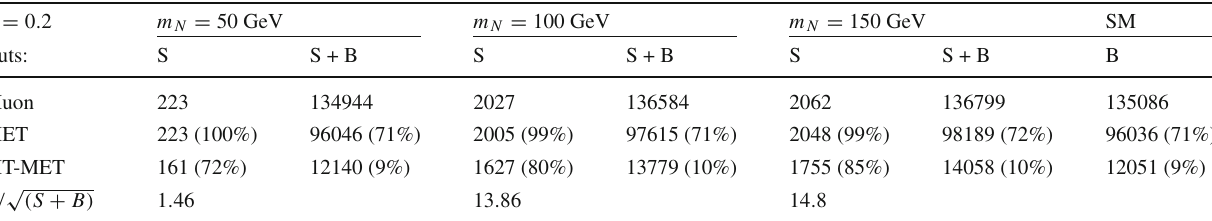
( a ) (b) Fig. 6 Number of events distribution with MT-MET( μ ) variable ( a ) and A FB distribution with E μ for signal plus background (S + B) and SM j μ √ s = 500 GeV, L = 500 fb − 1 background-only (B) events for α = 0 . 2, (cid:5) = 1 TeV, Table 3 e + e − → νμ − jj (semi-leptonic). Number of events for signal- Muon cut: one muon in the final state. MET cut: select MET > 25 only (S), signal and SM background (S + B, generated with interfer- √ s = 500 GeV, L = 500 fb − 1 . ence), and SM background (B) for